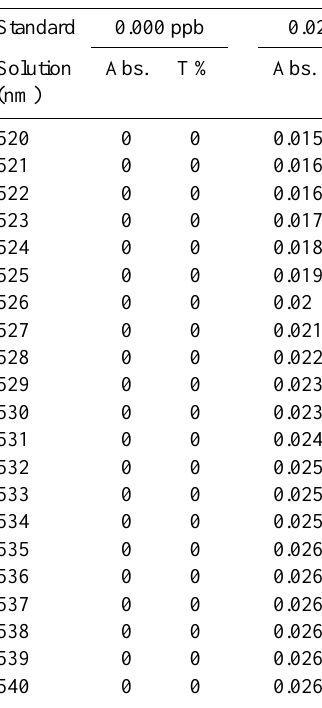
Figure 3. Suction system to rectify fogging problem and stabilizer to control voltage variation. Figure-3: Suction System to Rectify Fogging Problem and Stabilizer to Control Voltage Variation Table 1. Absorbance of standard solution at di ff erent λ